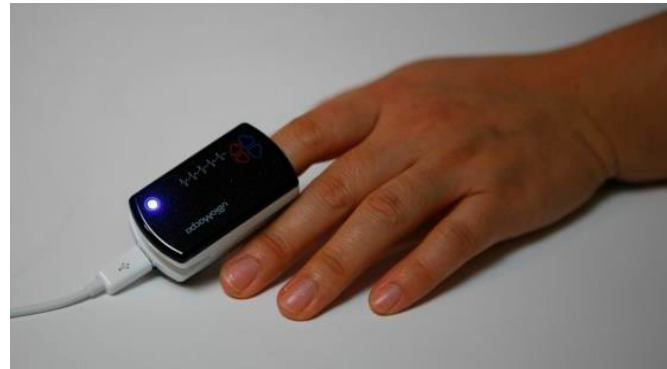
Figure 2. Image of the PPG measurement. Table 4. Specifications of the PPG measurement device.